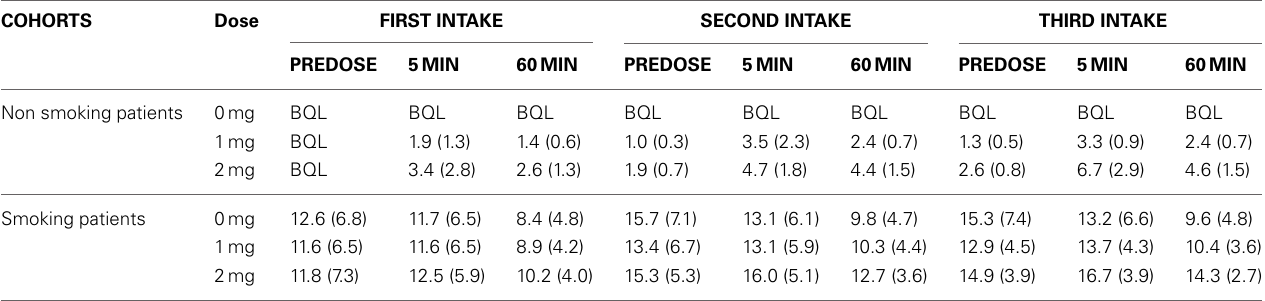
Table 2 | Mean plasma concentration nicotine